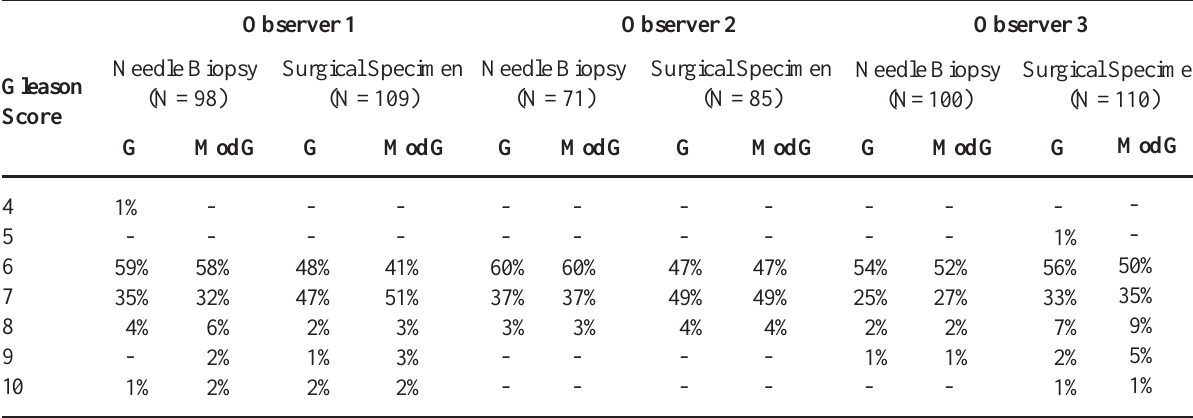
G = percentage of traditional Gleason score; Mod G = percentage of modified Gleason